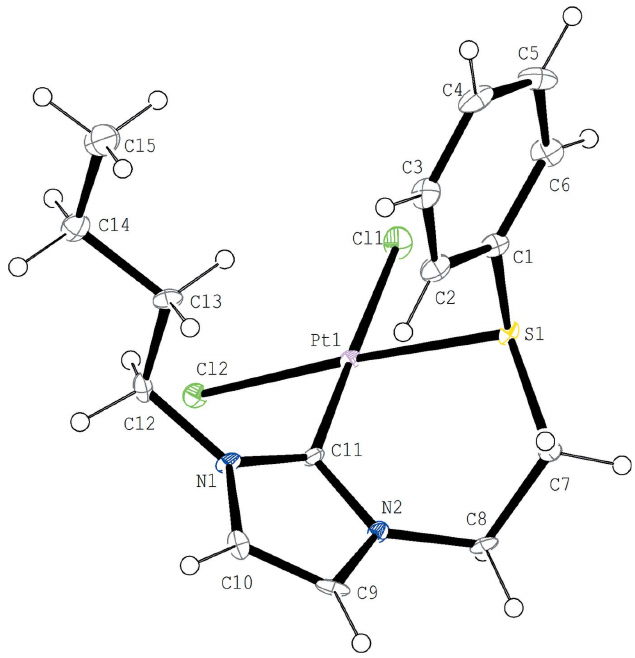
Figure 1 The structure of the title complex, with the atom-labelling scheme. Displacement ellipsoids are drawn at the 30% probability level.